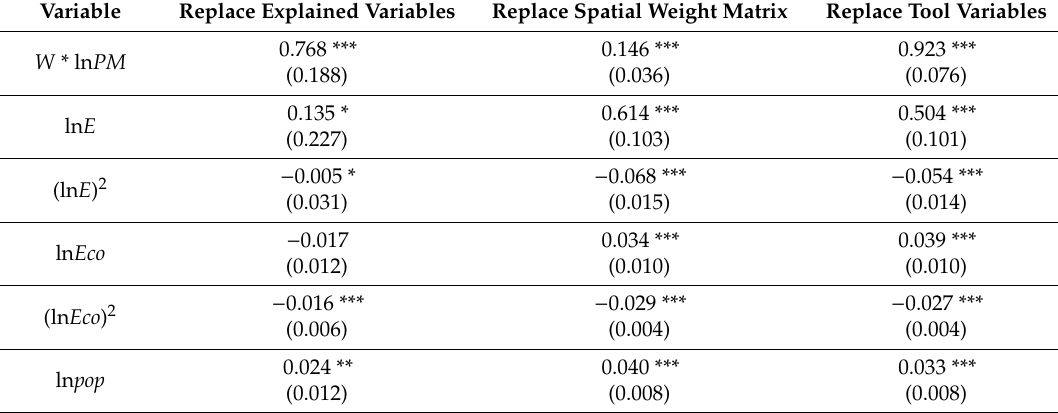
Table 3. Robustness